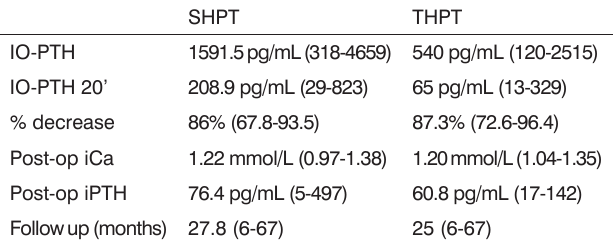
Table 3. Intra-operative PTH decay in cured